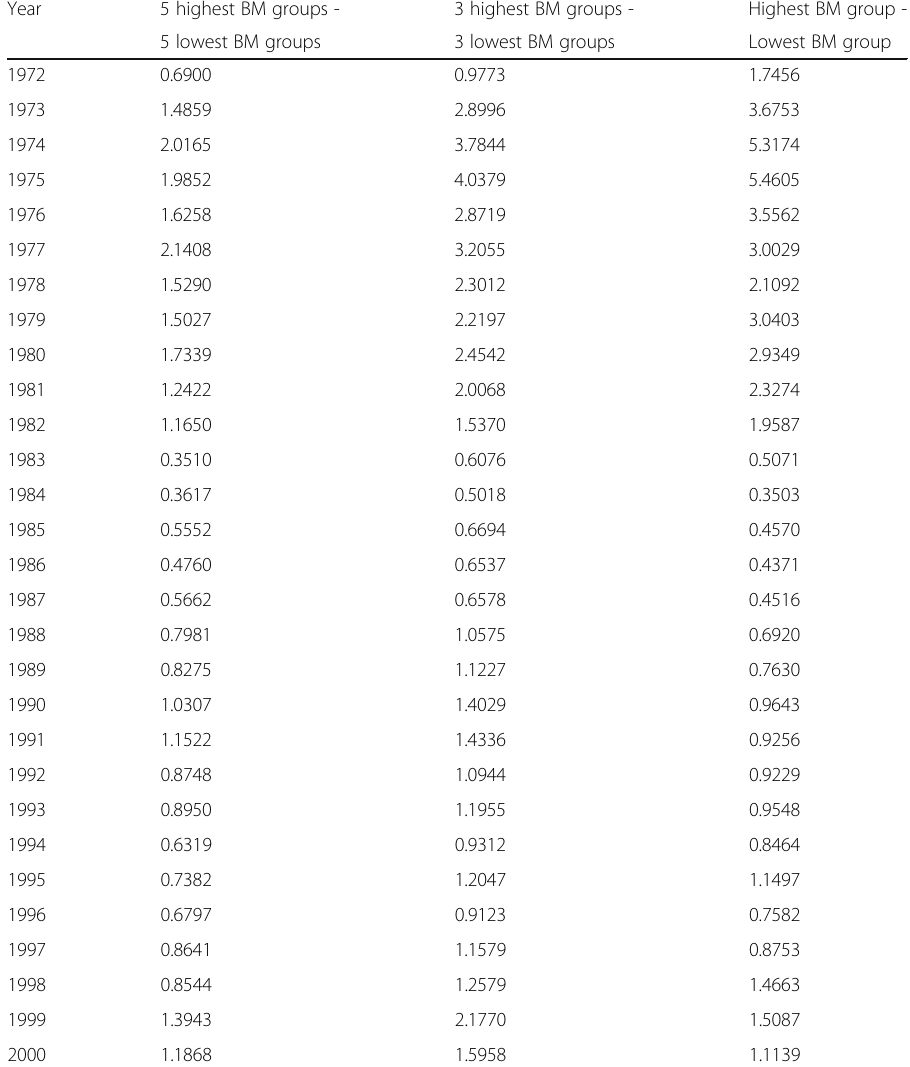
Table 4 Annual differences in average return and illiquidity for value and glamour portfolios. The difference in average return and the percentage difference in illiquidity is reported for each year in the sample period 1968 – 2000. The average return value is the annual average return over the 5 year post-portfolio formation period. The average illiquidity value is the annual average normalized illiquidity over the 5 year post-portfolio formation period. Both measures are reported for the difference between the five, three, and single highest and lowest BM groups (Continued) Year 5 highest BM groups - 3 highest BM groups - Highest BM group - 5 lowest BM groups 3 lowest BM groups Lowest BM